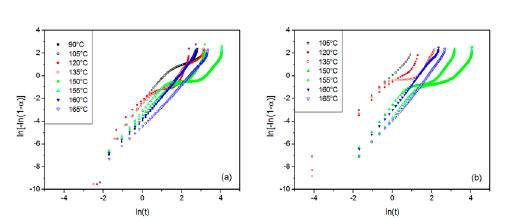
Figure 7. Avrami analysis for (a) scPLA and (b) scPLA/GNPO+ nanocomposite isothermally crystallized at various crystallization temperatures.